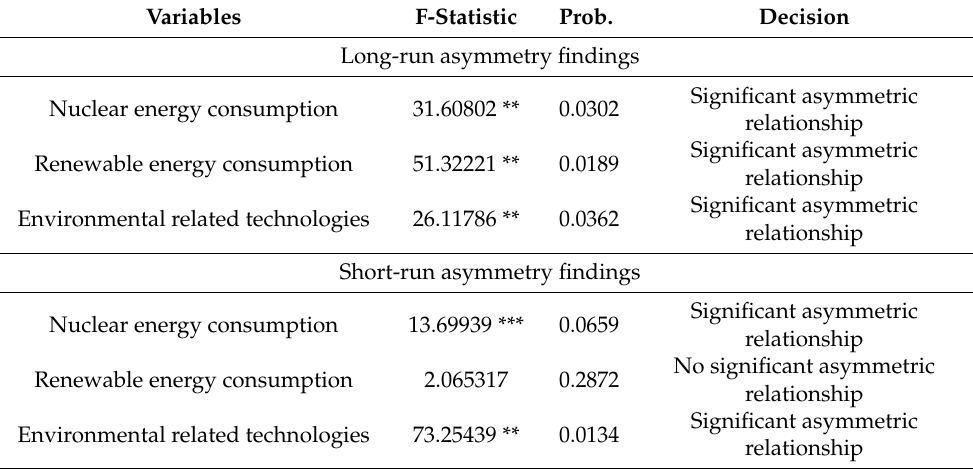
Table 12. Test to check long-run